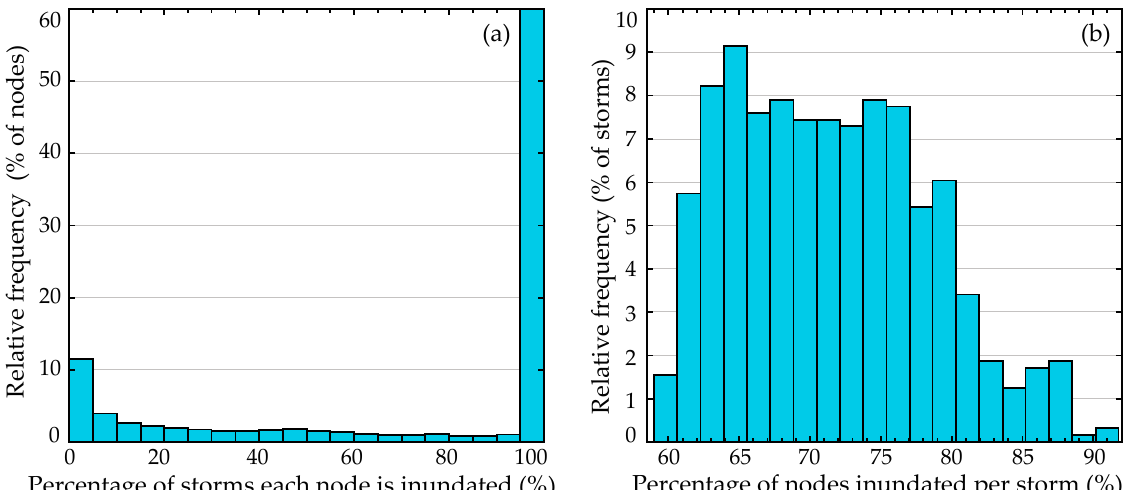
Figure 4. Information about wet/dry conditions for nodes and storms, expressed as histograms of ( a ) the percentage of storms that each node is inundated for, and of ( b ) the percentage of nodes that are inundated for each storm. Both histograms are presented as relative frequency plots (making the y -axis also a percentage of the corresponding characteristic, nodes or storms, respectively).